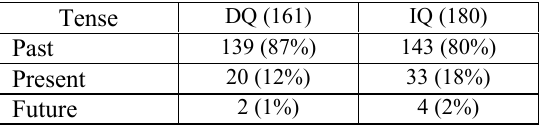
Table 2: The tense of verbs of